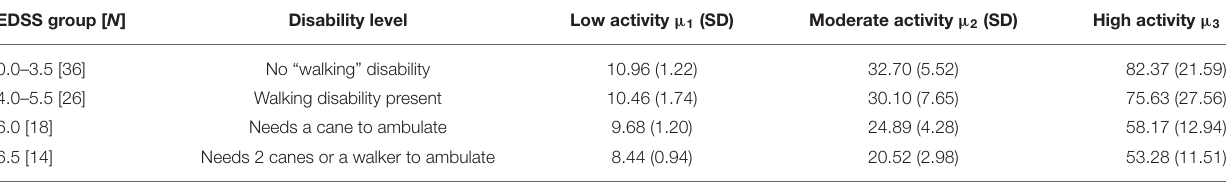
TABLE 3A | Mean physical activity level distribution per disability (EDSS) group (distribution of µ ).